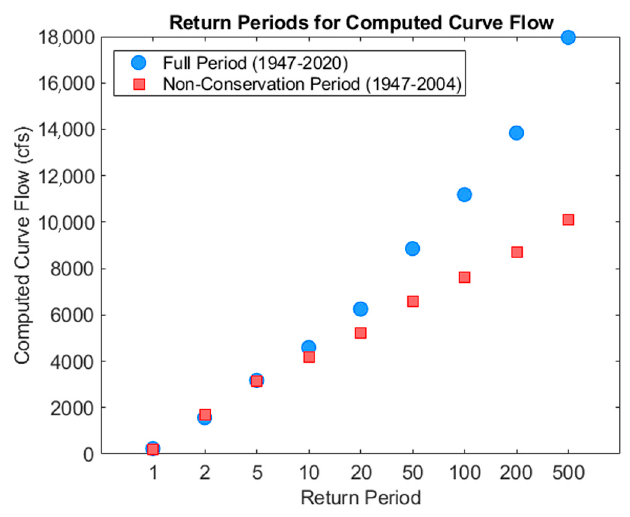
Figure 6. Return periods for the computed curve flows of the full period and the non-conservation period.